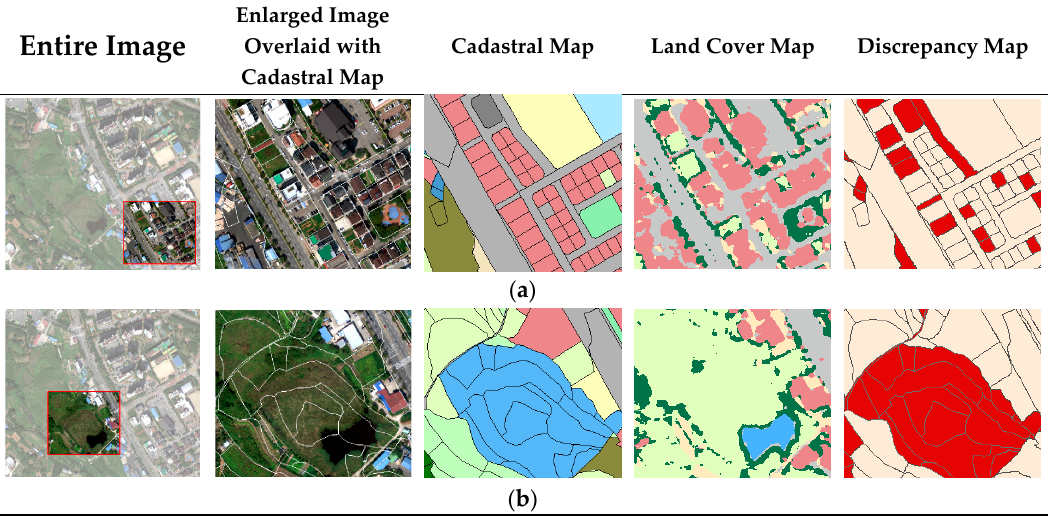
Figure 13 . Enlarged hyperspectral UAV images, cadastral maps, land cover maps, and discrepancy maps in two zones of Site 1: ( a ) subset-1 and ( b ) subset-2.